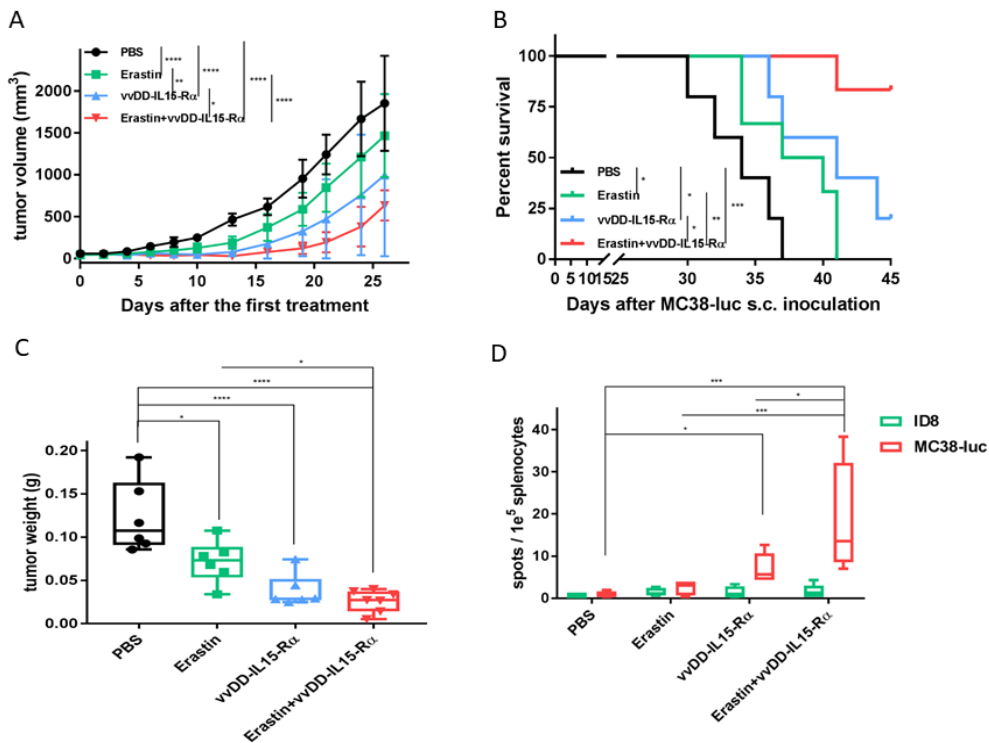
Figure 5. Combination therapy improved therapeutic efficacy and elicited potent anti-tumor im- munity in MC38-luc tumor model. ( A , B ) B6 mice were inoculated subcutaneously with 5.0 × 10 5 MC38-luc tumor cells in 60 µL volume and randomly divided into required groups. Data are quantified ( n = 5 in PBS and vvDD-IL15-R α groups; n = 6 in erastin and dual therapy groups). When tumor nodules reached ~5 × 5mm, vvDD-IL15-R α were intratumorally (i.t.) injected with 2.0 × 10 7 pfu/50 µ L for only one injection, erastin was intraperitoneally (i.p.) injected daily with 20 mg/kg for seven injections. ( A ) The graph represents a comparison of tumor growth in different treatment groups. ( B ) The survival of tumor-bearing mice was monitored using Kaplan–Meier analysis and statistical analyses were performed using a log rank test. ( C , D ) Another group of B6 mice was treated with the same time schedule as A and B; tumor nodules and spleens were collected and analyzed eight days post treatment. ( C ) Tumor nodules were collected and weighed. ( D ) ELISpot assay resulted in quantities of IFN- γ spots in the different treatment groups. Values are presented as mean ± SD. Two-way ANOVA was used to analyze the data in ( A , B , D ). One-way ANOVA was used to analyze data from panel C (*, p < 0.05; **, p < 0.01; ***, p < 0.001; ****, p < 0.0001). Parts of this experiment were performed three times and similar results were obtained.